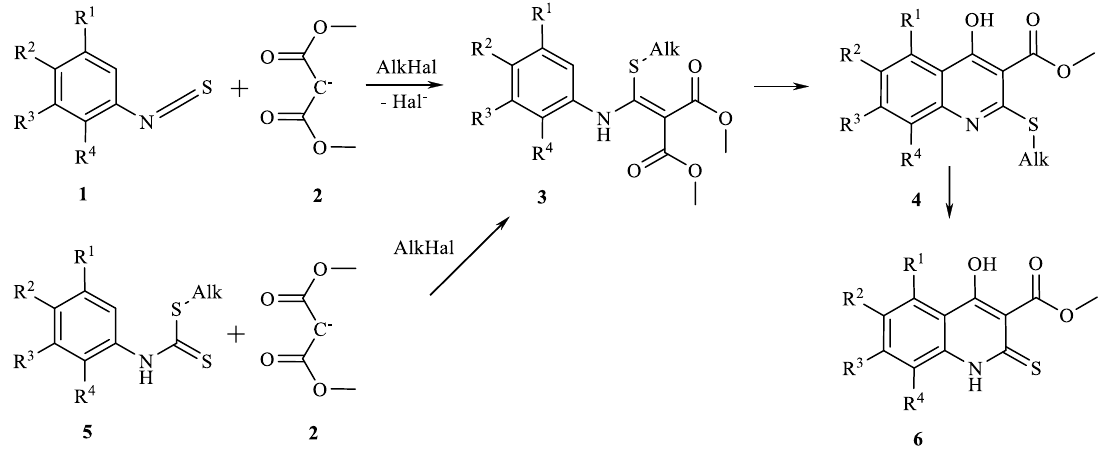
Scheme 1. General route to 4-hydroxy-2-thioxo-1,2-dihydroquinoline-3-carboxylate 6 synthesis.